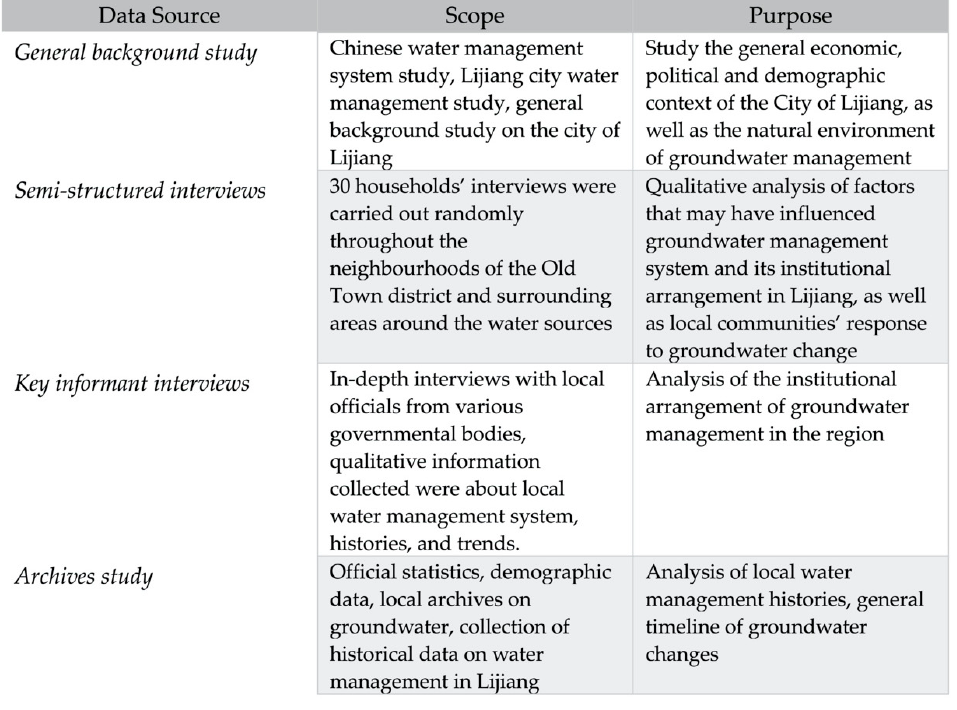
Figure 2. Summary of case study.